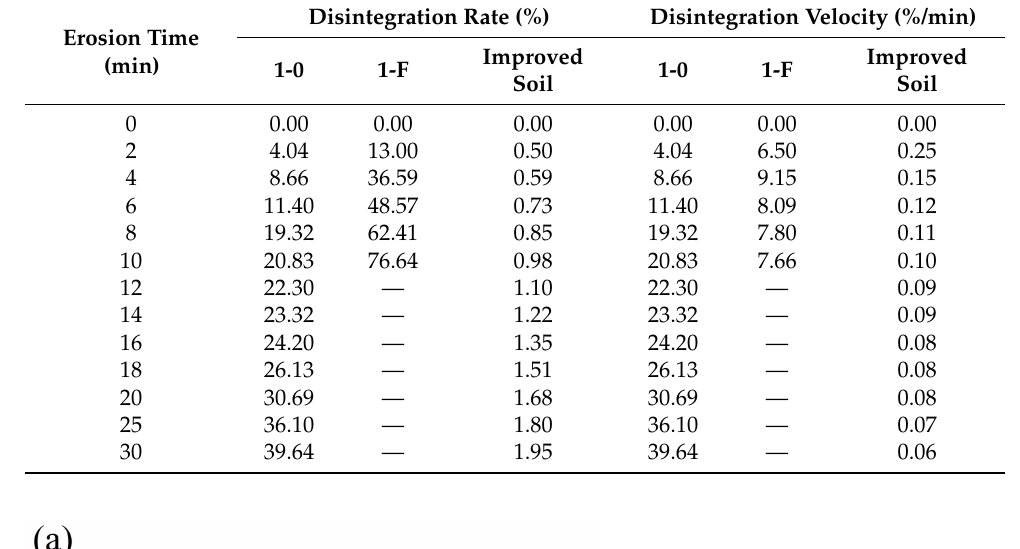
Table 7. Disintegration rate and disintegration velocity of samples.